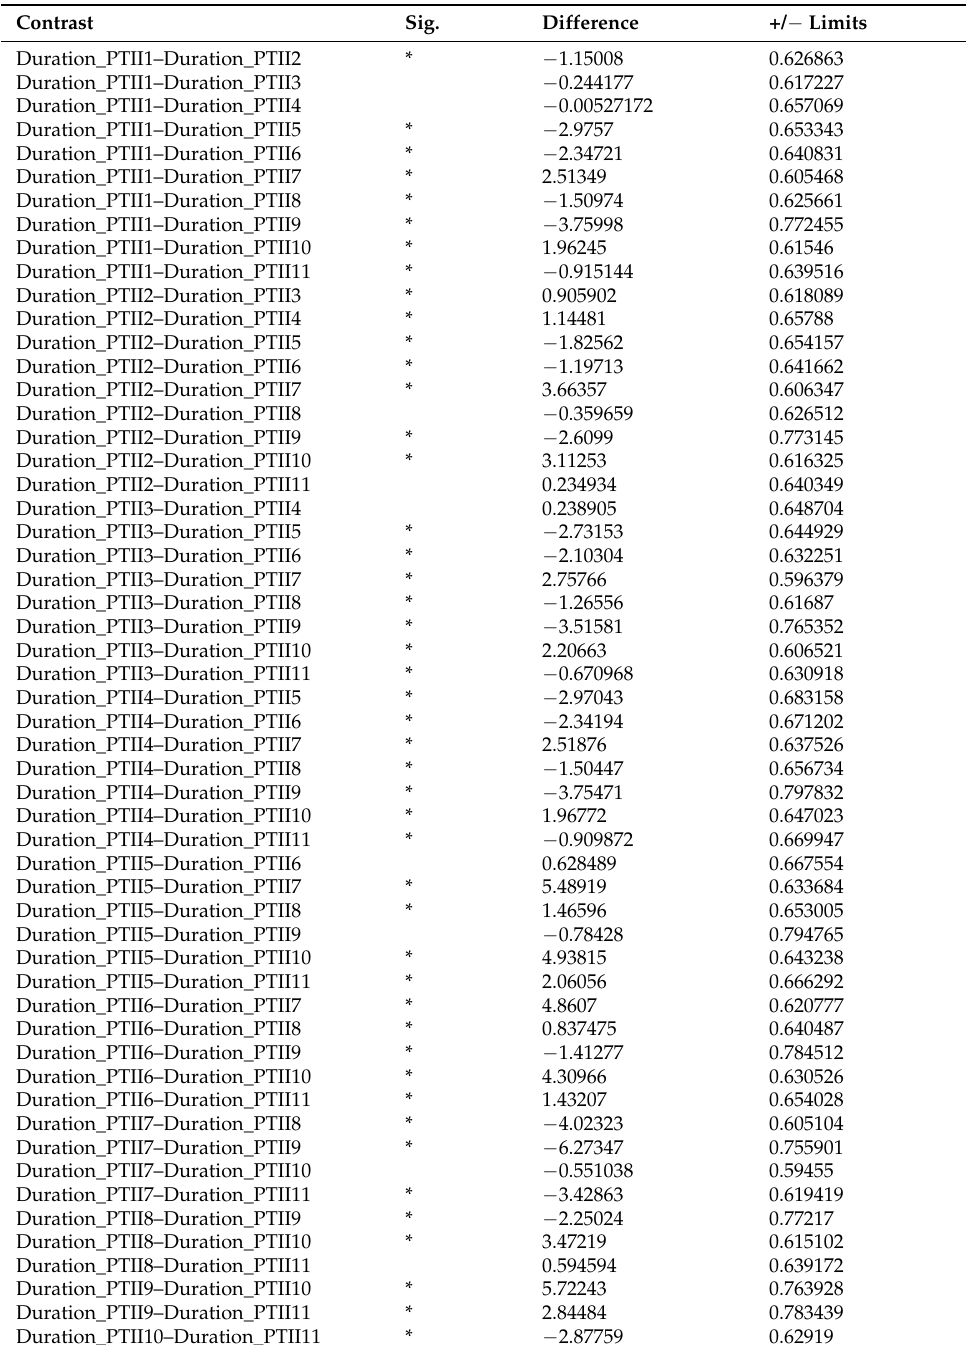
Table A1. Contrast table correlated with Table